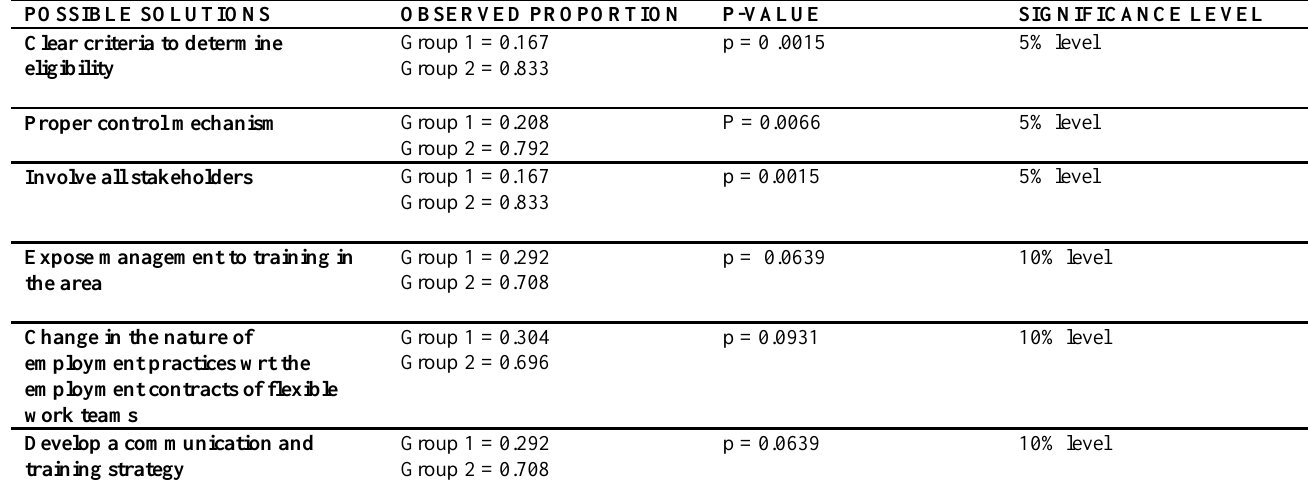
Table 11: Possible solutions for implementing FWP POSSIBLE SOLUTIONS OBSERVED PROPORTION P-VALUE SIGNIFICANCE